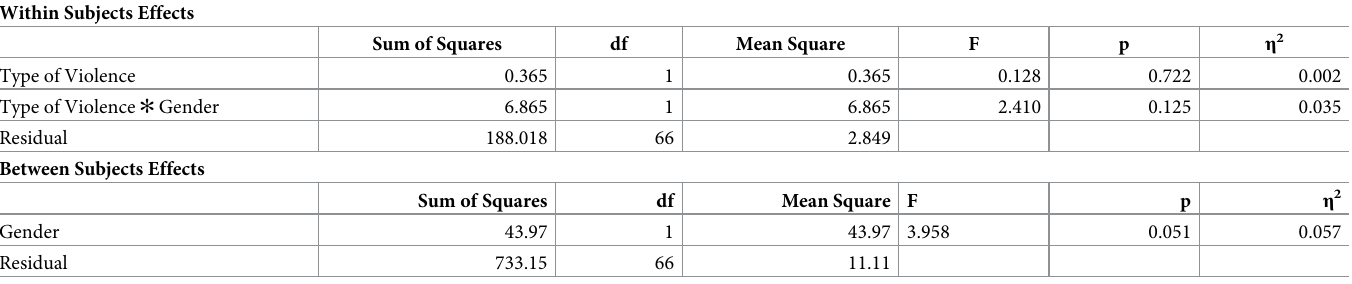
Phase 2: Raters rate narrations from Phase 1. Participants . For Phase 2, 340 participants were recruited (170 Women, 18–73 years, M = 34.95 years, SD = 12.18 years) from the same panel of participants as Phase 1. The same inclusion criteria from Phase 1 were used. Partici- pants in Phase 1 were excluded from Phase 2. Material and procedure . The second questionnaire consisted of making seriousness ratings of narrations from Phase 1. The questionnaire included the same information as in Phase 1, except no narratives were collected. The written narrations collected in Phase 1 were distrib- uted into 17 groups of eight narrations: four of physical violence and four of psychological vio- lence. The four physical-violence narrations were from different individuals than the four psychological narrations. For example, those who rated the psychological narrations from group 1 rated the physical narrations from group 2. To control for gender, ten men and ten women rated each narration. The order of the presentations of the physical and the psycholog- ical violence severity ratings were counterbalanced across participants, so the two types of